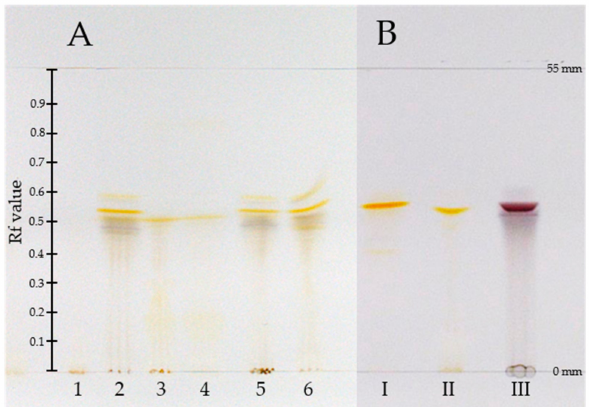
Figure 1. High-performance thin-layer chromatograph (HPTLC) of ( A ) methanolic crude extracts of C.